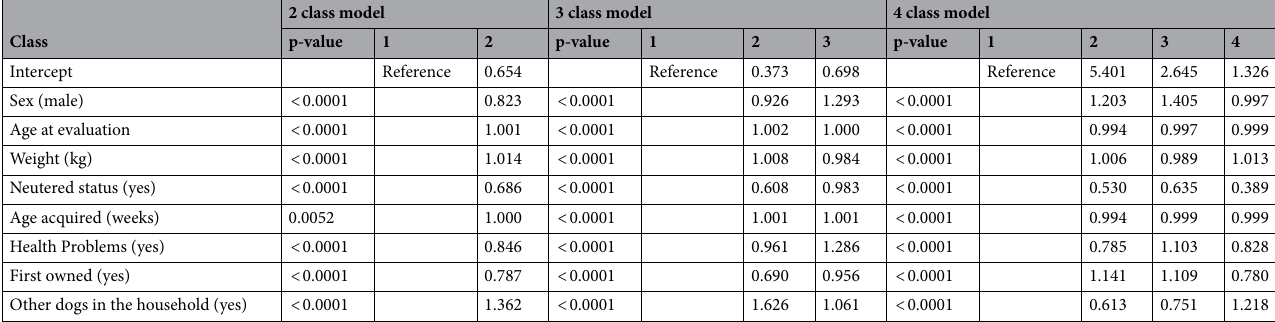
Table 1. Odds ratio effect size estimated for covariates in the models. Estimates are presented separately. For continuous variables, estimates are for a one-unit